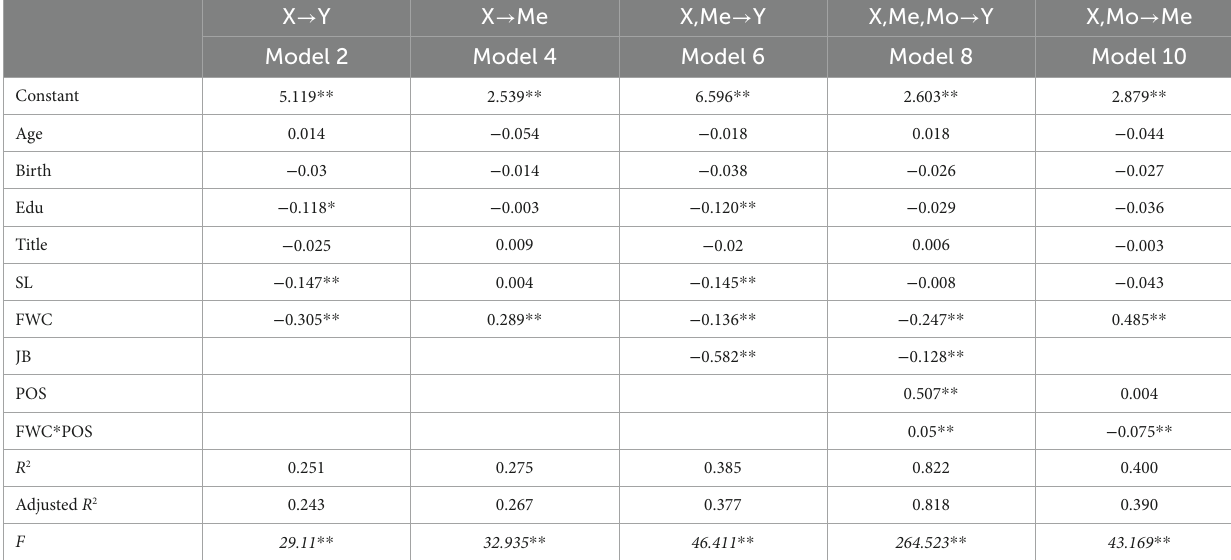
TABLE 4 Regression analysis results of main effect, mediating effect and moderating effect of